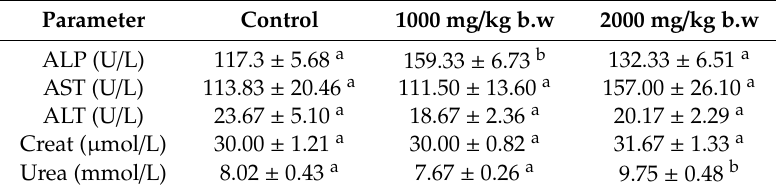
Table 3. E ff ects of IP 6 -CS-MNPs on liver and kidney biochemical parameters. Table 3. Effects of IP 6 -CS-MNPs on liver and kidney biochemical parameters.